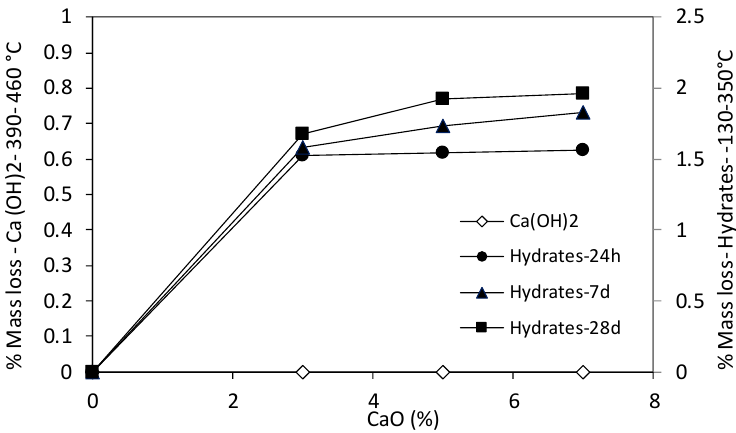
Figure 8. Quantitative interpretation of thermogravimetric analyses of lime-treated bentonite at increasing lime